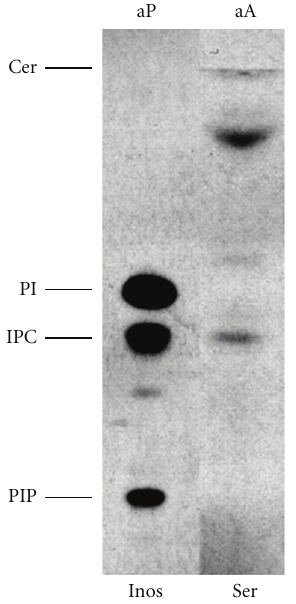
Figure 6: HPTLC analysis of axenic amastigotes (aA) metabolically labelled with tritiated serine (Ser; 1 . 25 × 10 7 cell equivalent). Axenic promastigotes (aP) similarly labelled with tritiated inositol (Inos; 5 × 10 6 cell equivalent) served as markers. Following fluorography the plate was exposed to film for 15 days. PIP: phosphatidylinositol phosphate; IPC: inositol phosphorylceramide; PI: phosphatidyli- nositol; Cer: ceramide, migrating at solvent